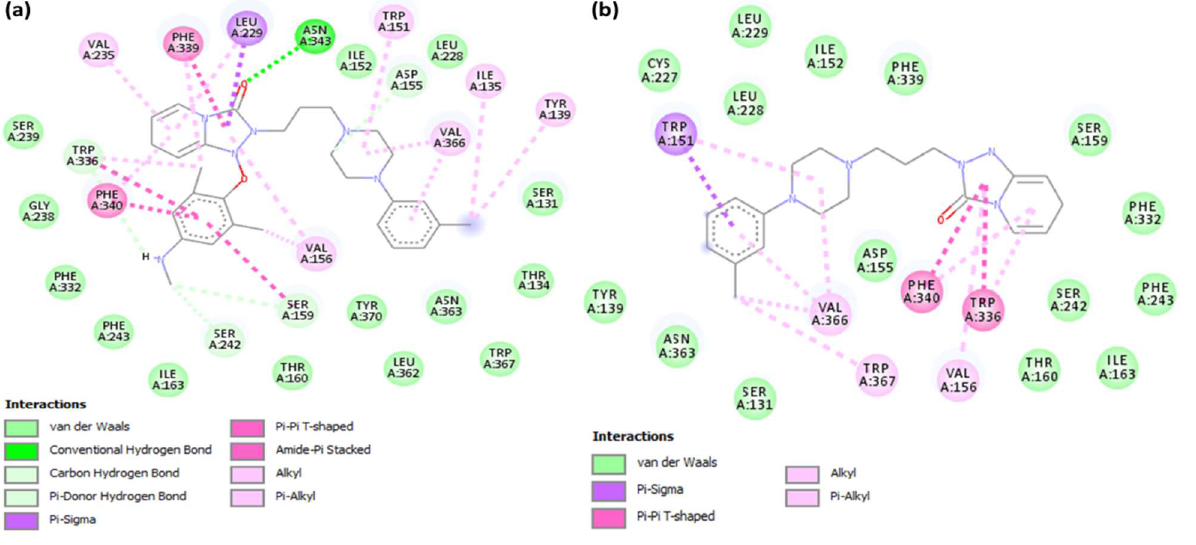
Figure 11. 2D structure of the interactions between serotonin with ( a ) [(TZD)(DCQ)] or ( b ) TZD alone.